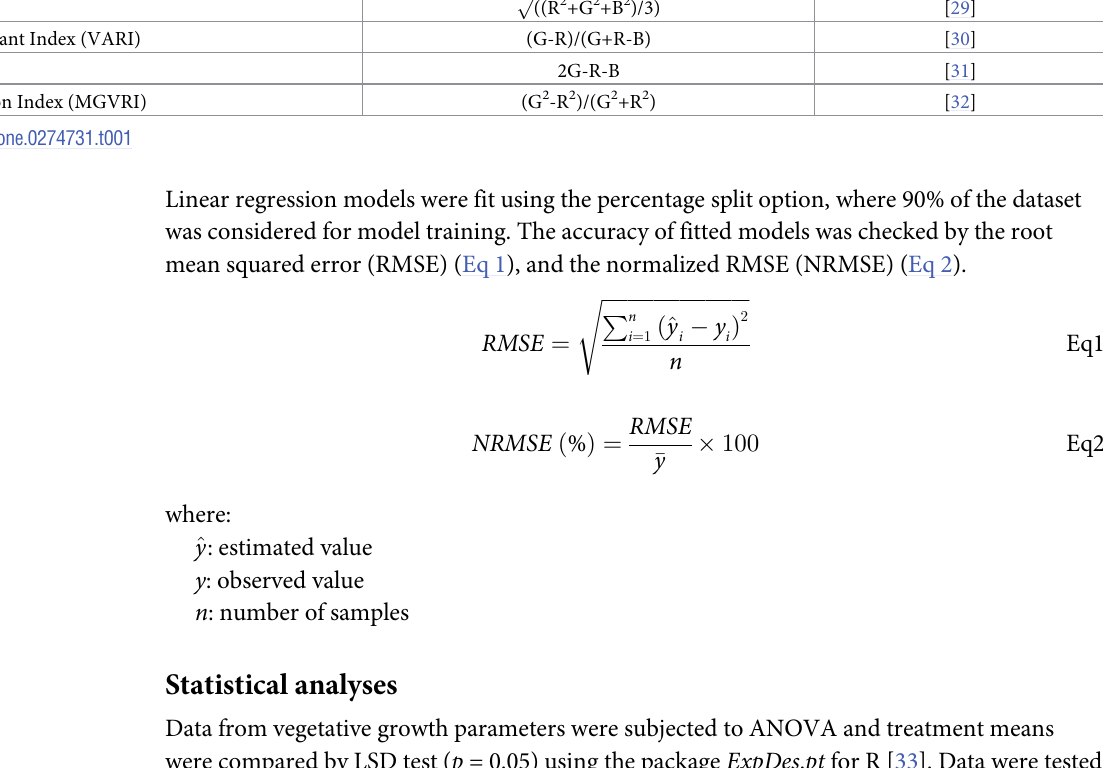
Table 1. Equations for calculation of vegetation indices from red (R), green (G), and blue (B) bands of